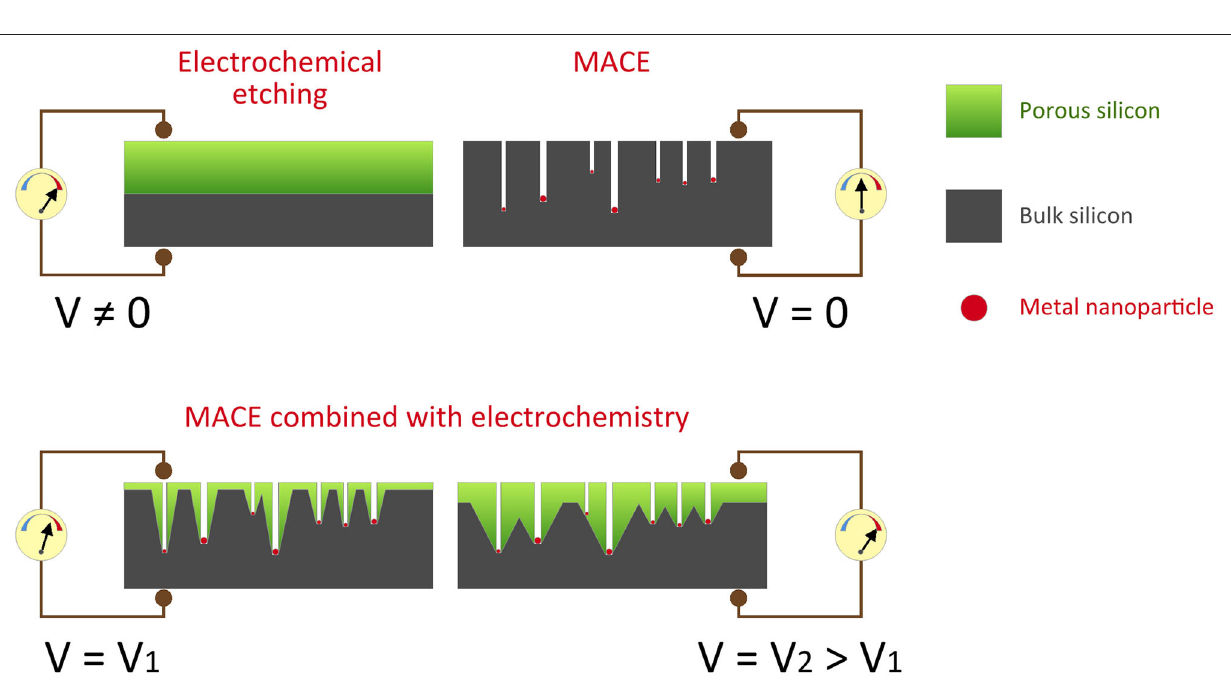
current. In the vast majority of cases, only the base of the macropores remains due to the superposition of the porous silicon